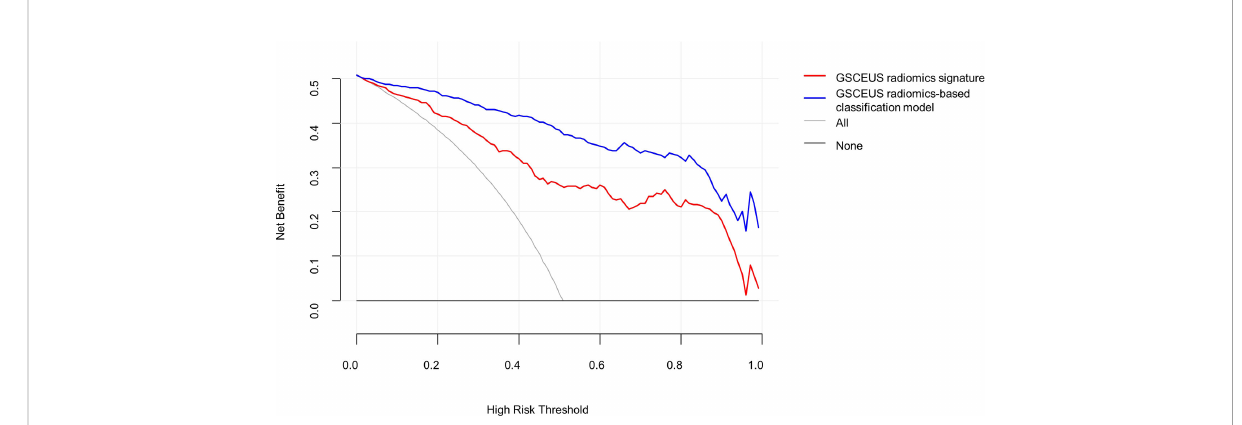
FIGURE 6 Decision curve analysis (DCA) derived from the validation group. The y-axis measures the net bene fi t. The net bene fi t is determined by calculating the difference between the expected bene fi t and the expected harm associated with each proposed model. If the threshold probability was more than 2%, using the nomogram to predict IMSPDM/DE added more bene fi t than either the treat-all scheme (grey line) or the treat-none scheme (dark black